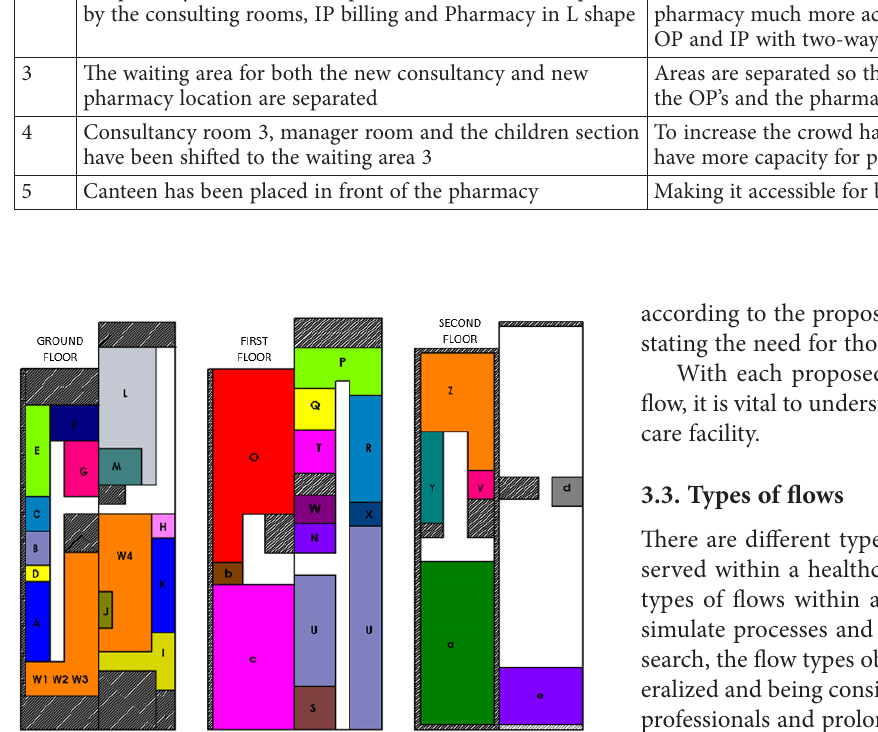
Figure 6. Proposed layout 4 (Plan